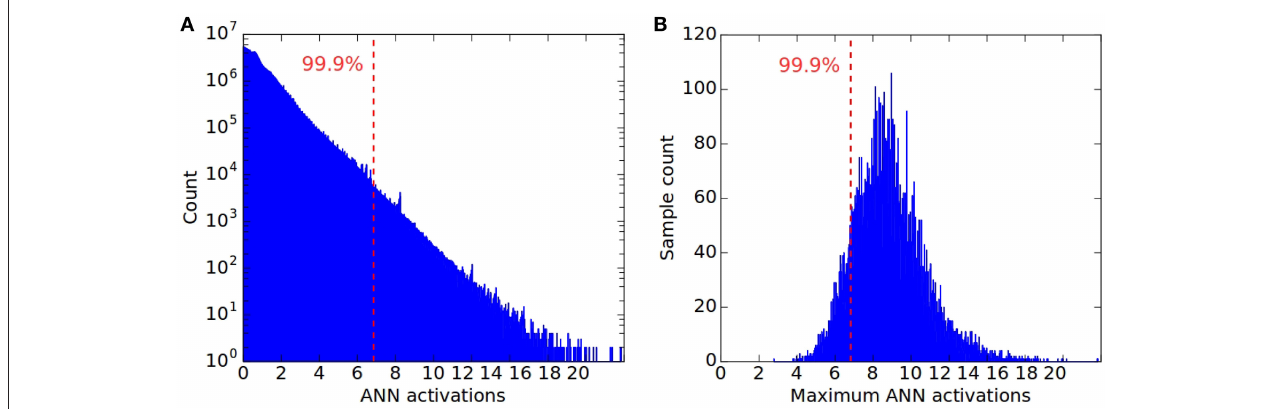
FIGURE 1 | Distribution of all non-zero activations in the first convolution layer of a CNN, for 16666 CIFAR10 samples, and plotted in log-scale. The dashed line in both plots indicates the 99.9th percentile of all ReLU activations across the dataset, corresponding to a normalization scale λ = 6.83. This is more than three times less than the overall maximum of λ max = 23.16. (B) Distribution of maximum ReLU activations for the same 16666 CIFAR10 samples. For most samples their maximum activation is far from λ max . (A) ANN activations; (B) Maximum ANN